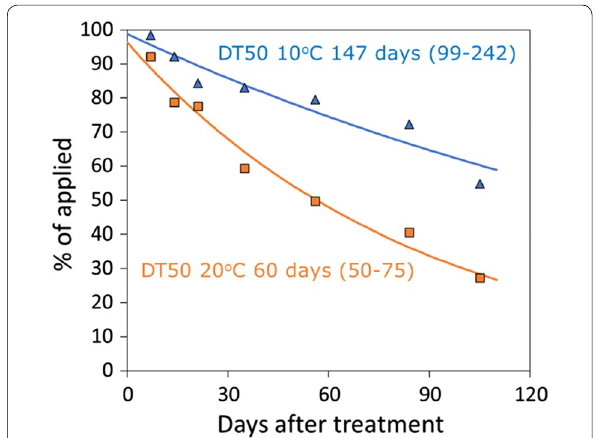
Fig. 3 Measured residues of a PPP in soil at two temperatures ( symbols ) and optimised decline curves ( lines ), with 95% confidence intervals of the optimised half-life in